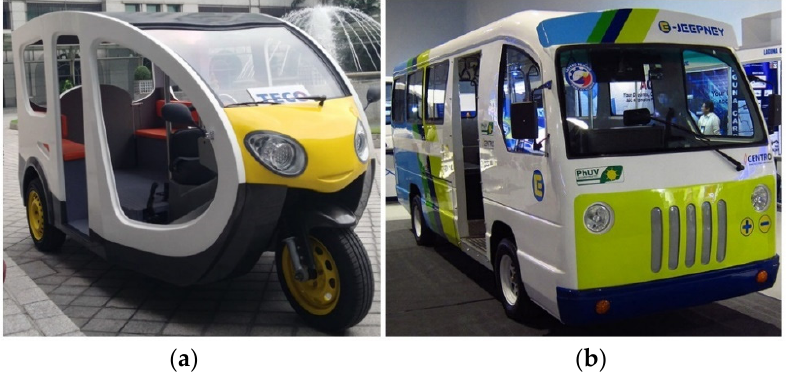
Figure 1. Modernized public utility vehicles (PUVs) in the Philippines: ( a ) e-trike and ( b ) e-jeepney. Source: Top Gear Philippines.